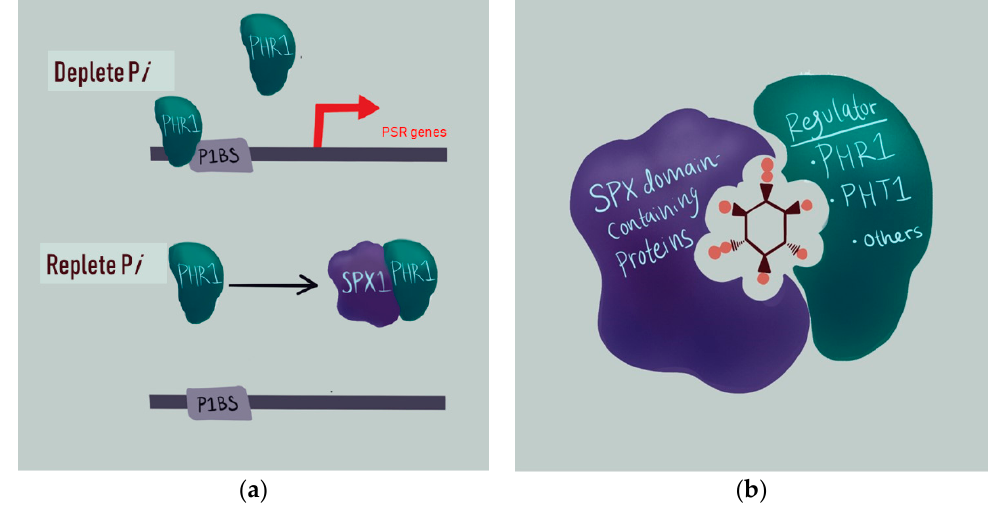
Figure 4. Model depicting how PP-InsPs regulate plant P i sensing and the P i starvation response (PSR). ( a ) PSR gene regulation under deplete (top) and replete P i conditions (bottom). SPX1 binds to PHR1 under replete P i , preventing SPX1 from binding to promoters containing P1BS. Under deplete P i , PHR1 is uninhibited from binding to P1BS promoters. Adapted from [60]. ( b ) Model depicting a complex formation between SPX1, PHR1, and InsP 8 . This model represents interactions between other SPX proteins and PSR regulators, such as PHR1 and its homolog, PHT1, along with others. While InsP 7 has a ~7-fold stronger binding affinity than InsP 6 to OsSPX4, recent genetic analyses